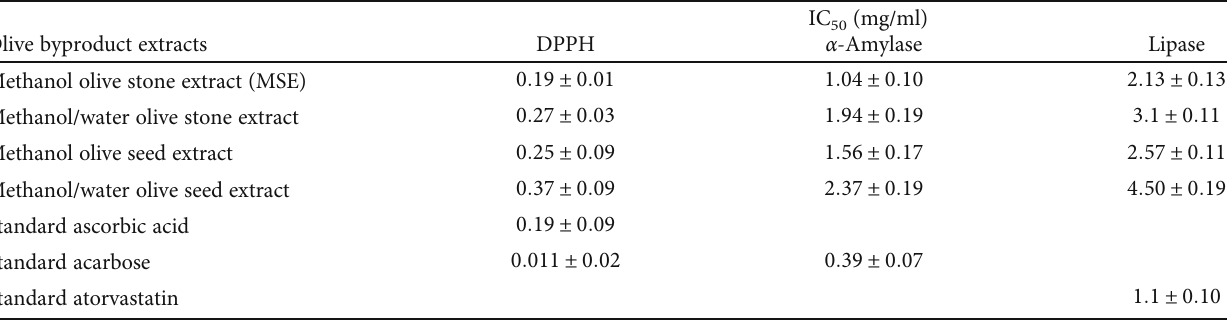
Table 3: Antilipase and anti α -amylase inhibition activities (% of inhibition) of methanol, hexane, and water olive byproducts extracts (IC mg/ml) at di ff erent concentrations ( n = 3